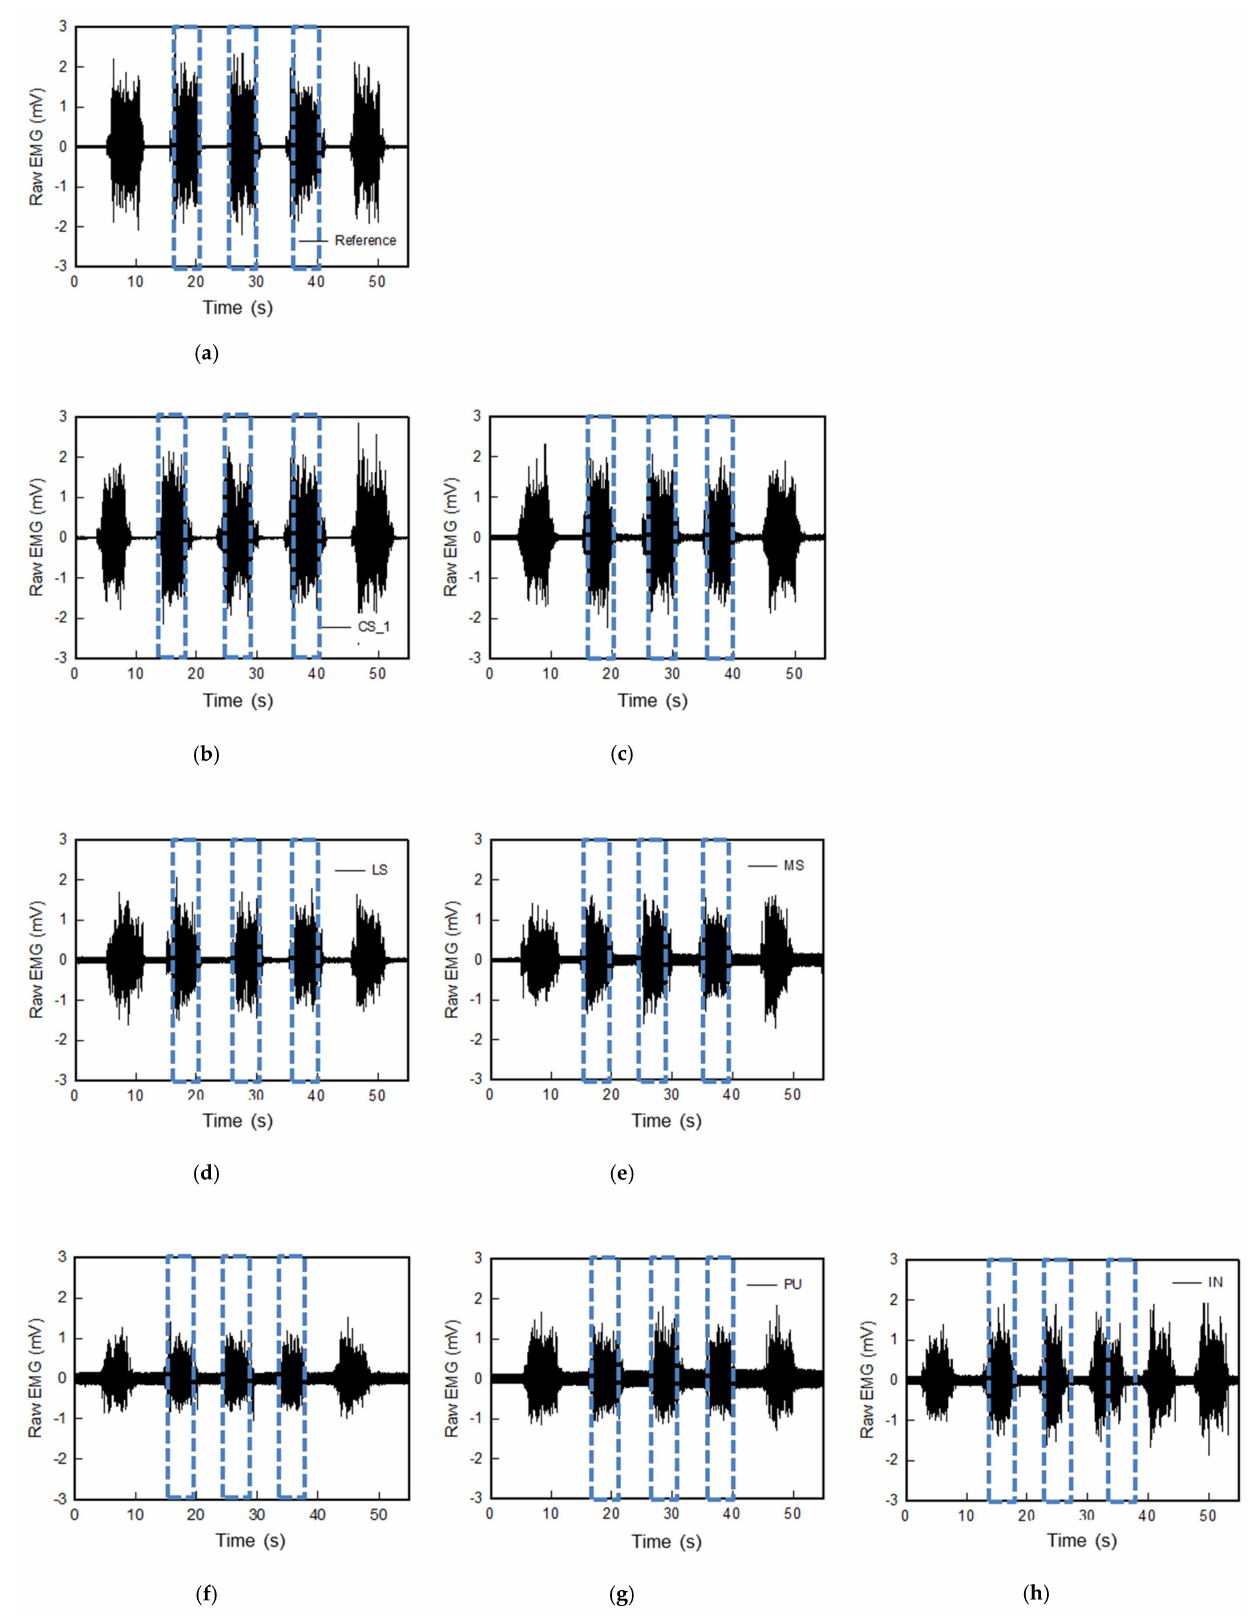
Figure 6. Graph of raw sEMG signals obtained via various electrodes; ( a ) reference, ( b ) CS_1, ( c ) CS_2, ( d ) Em_LS, ( e ) Em_MS, ( f ) Kn_PL, ( g ) Kn_PU, and ( h ) Kn_IN,